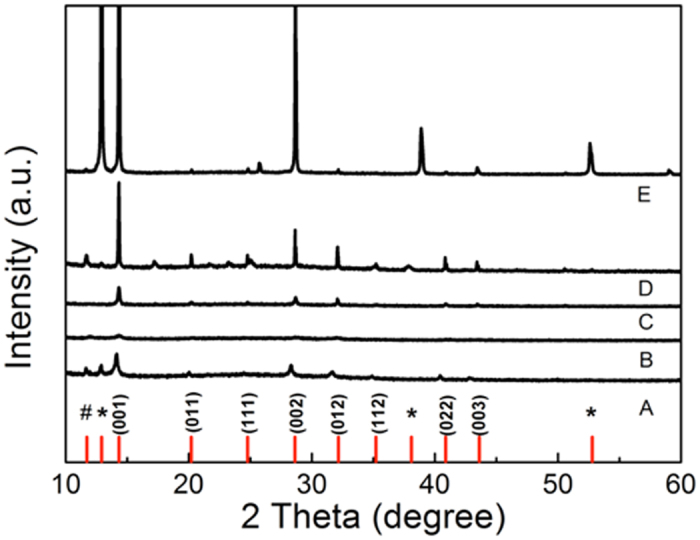
XRD patterns for different perovskite thin-films.Annealed FAPbI3 (A), unannealed FMC (B), annealed FMC (C), unannealed FMC with Pb(SCN)2 (D), and annealed FMC with Pb(SCN)2 (E). Note that the symbol ‘#’ and ‘*’ represents the δ-phase of FAPbI3 and the cubic PbI2, respectively.